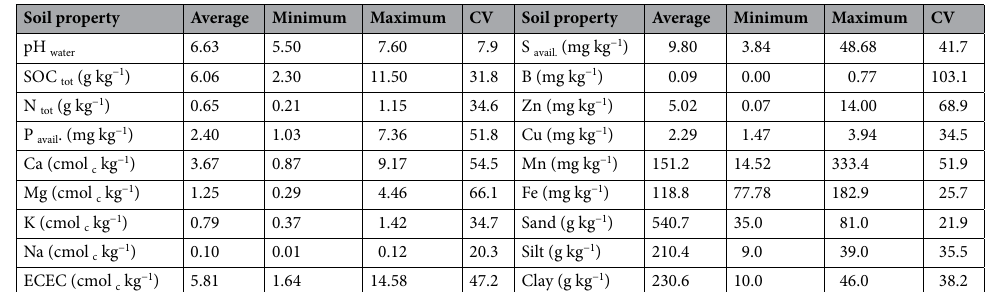
Treatment Yield (kg ha −1